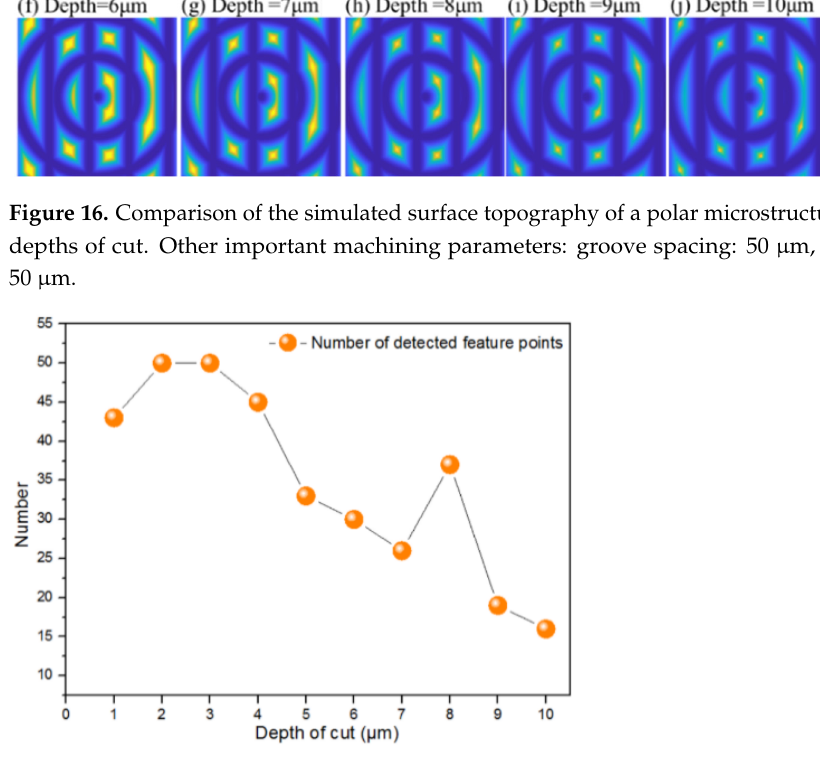
Figure 17. Trend of number of detected feature points (DFP) with different depths of cut.